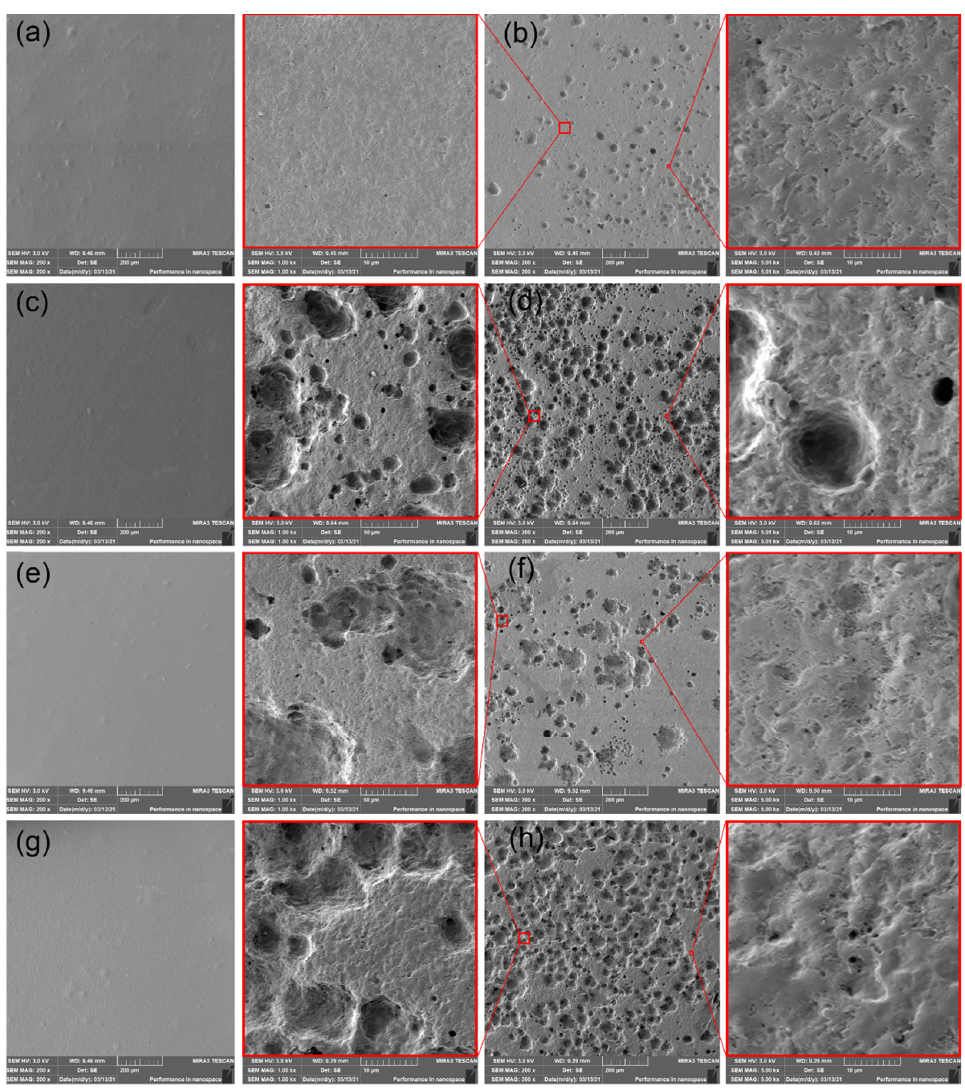
Figure 6. SEM images of ( a ) neat PHBV film at initial state, ( b ) neat PHBV film after 30 days of degradation in freshwater biotope, ( c ) PHBV/ATBC at initial state, ( d ) PHBV/ATBC film after 30 days of degradation in freshwater biotope, ( e ) PHBV/ATBC/L-CNC at initial state, ( f ) PHBV/ATBC/L-CNC film after 30 days of degradation in freshwater biotope, ( g ) PHBV/ATBC/CaCO 3 at initial state, ( h ) PHBV/ATBC/CaCO 3 film after 30 days of degradation in freshwater biotope.